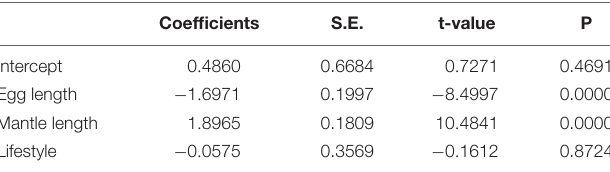
TABLE 3 | Parameters of the phylogenetic analysis of covariance (phylogenetic ANCOVA) of cephalopods obtained by phylogenetic generalized least squares (PGLS).